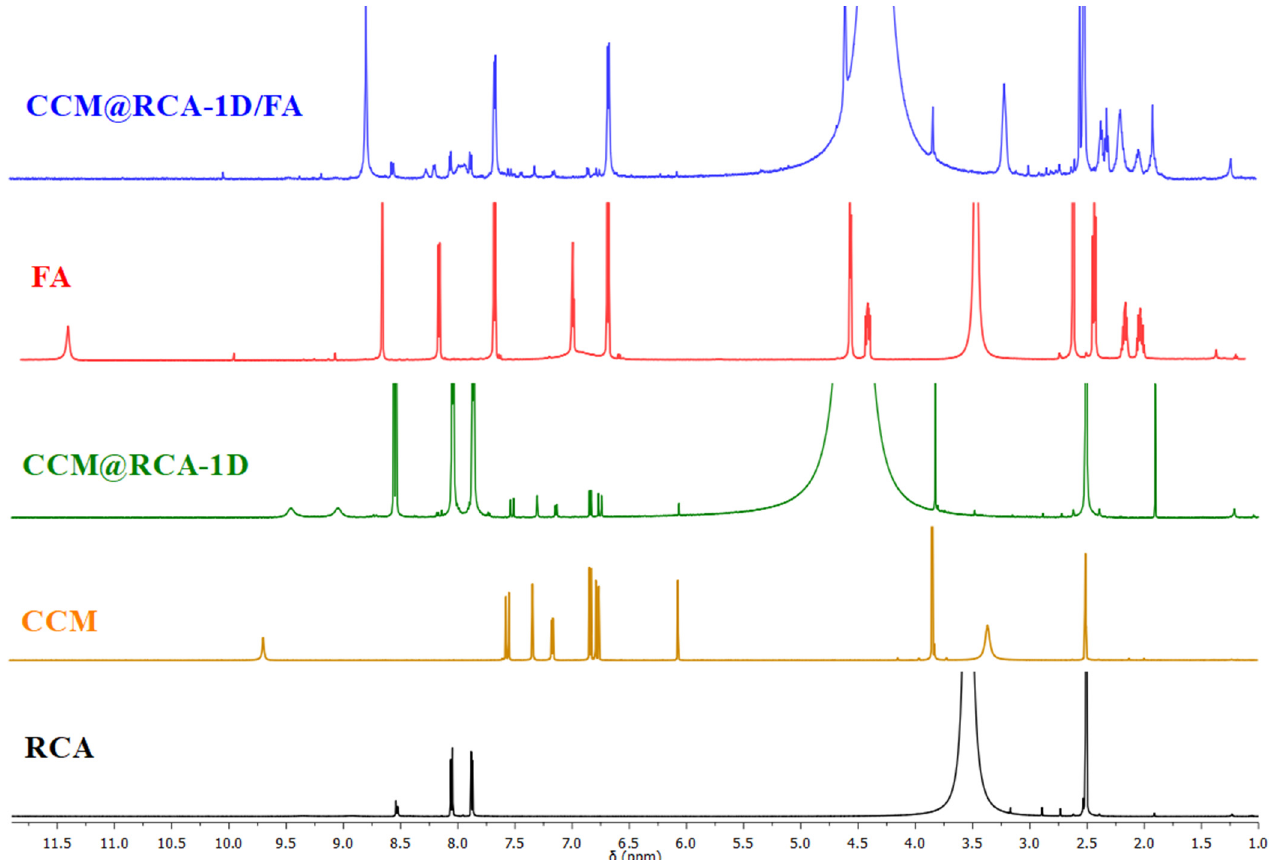
Figure 9. 1H NMR spectra for compounds RCA, CCM, CCM@RCA-1D, FA, and CCM@RCA-1D/FA, Figure 9. 1 H NMR spectra for compounds RCA, CCM, CCM@RCA-1D, FA, and CCM@RCA-1D/FA, in DMSO-d6. in